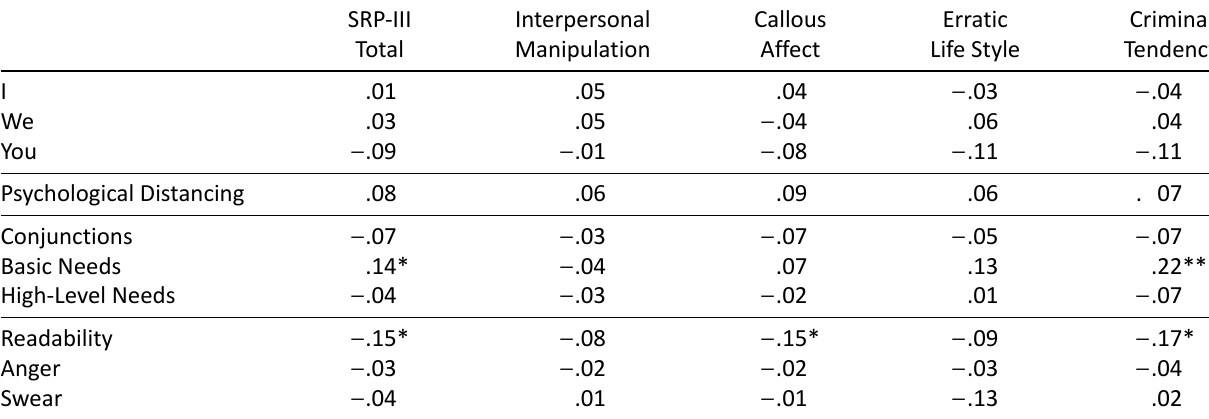
Table 3. Pearson bivariate 2-tailed correlations between SRP-III scores and selected linguistic factors in elicited